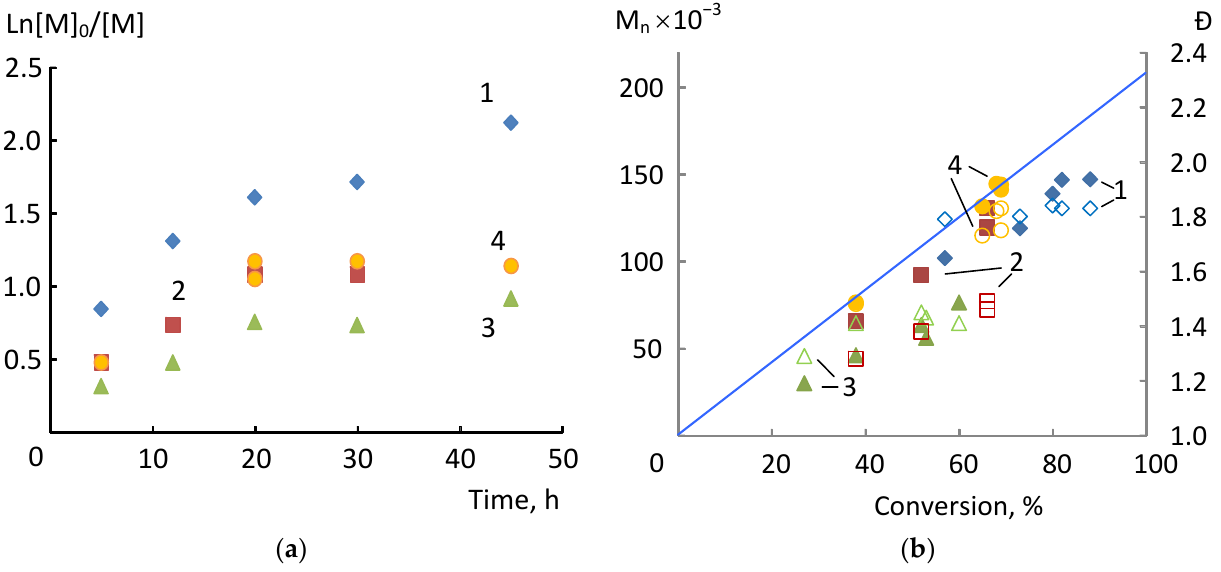
Figure 3. Tandem catalysis of AN polymerization in DMSO at 60 °C. [AN] = 4M. ( a )—The kinetic plot; ( b )—the dependences of M n and Đ on conversion. 1—[AN]:[2FBiB]:[CuBr 2 ]:[PMDTA]:[TPMA]:[RS]